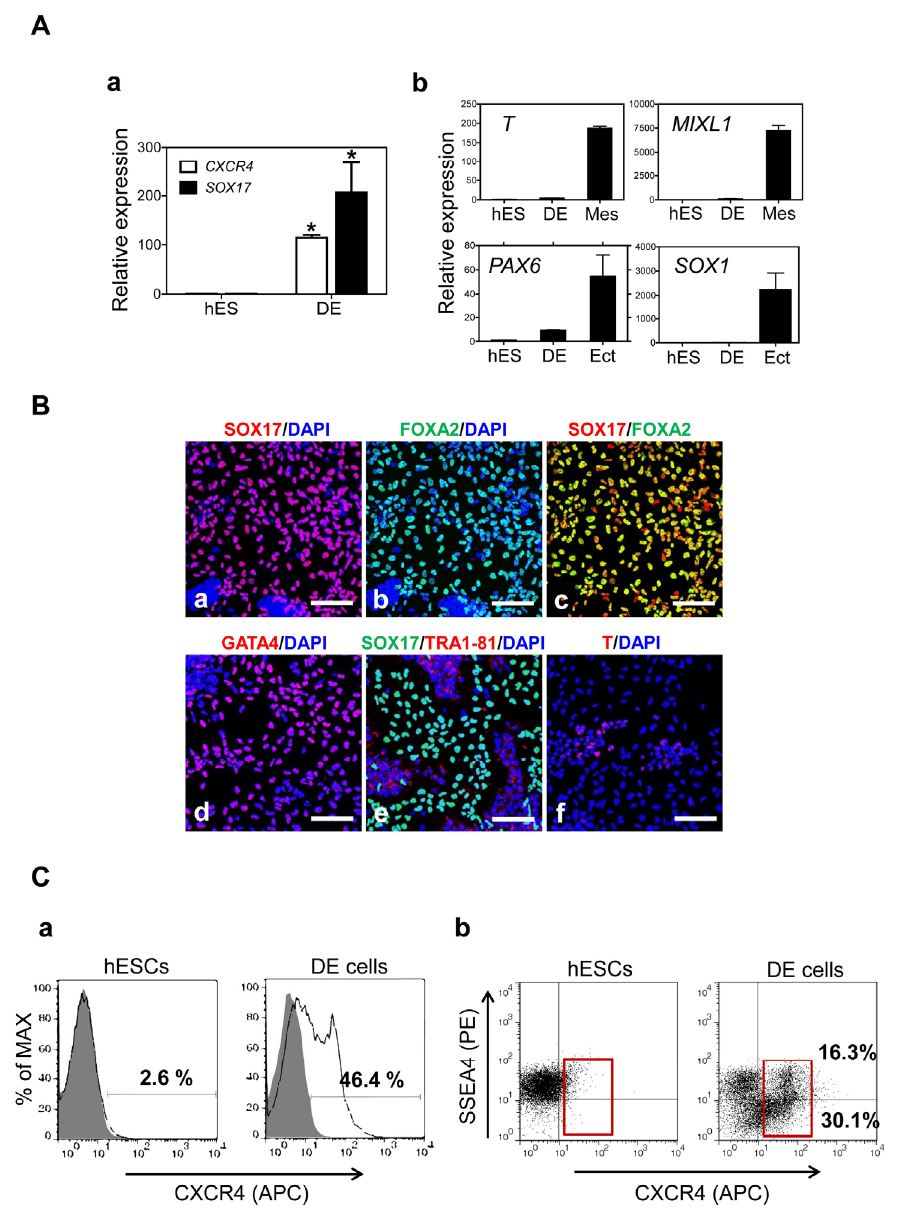
Figure 2. Induction of hESCs into DE cells. ( A ) ( a ) DE induction was confirmed by transcriptional expression of the DE marker genes CXCR4 and SOX17 . Relative expression of marker genes was normalized to GAPDH and the fold changes were shown as the mean ± SEM ( n = 3, * p < 0.05); ( b ) Heterogeneous differentiation into other germ layers in DE induction conditions, including mesoderm and ectoderm, was evaluated by expression of mesodermal ( T and MIXL1 ) and ectodermal genes ( PAX6 and SOX1 ). hESCs were used as a negative control. Mesoderm (Mes) and ectodermal (Ect) cells were used as positive controls; ( B ) Immunocytochemistry analysis of expression of ( a – d ) DE markers (SOX17, FOXA2 and GATA4); an ( e ) undifferentiated marker (TRA1-81); and a ( f ) mesodermal marker (T) in the DE cells. Scale bar = 200 μ m; ( C ) Flow cytometry analysis of ( a ) CXCR4 expression as a DE-specific marker; and ( b ) co-expression of CXCR4 and SSEA4 in hESCs and hESC-derived DE cells. Red boxes indicate the region of CXCR4-positive cells, with or without SSEA-4